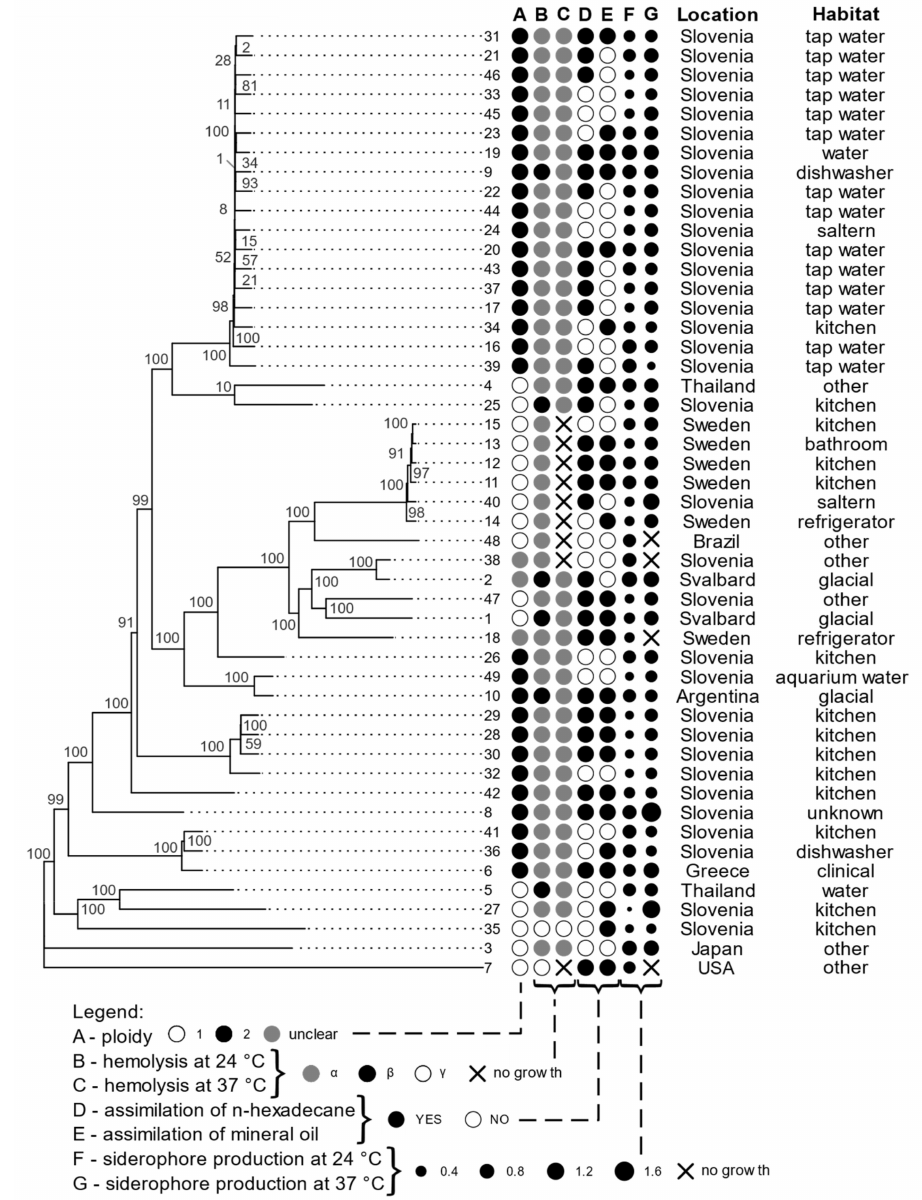
Figure 2. Phylogenomic tree of A. melanogenum strains based on whole-genome SNP data, with a selection of phenotypic traits, isolation location, and habitat. Column A of circles represents ploidy, B and C represent hemolysis at 24 ◦ C and 37 ◦ C, D and E show assimilation of n hexadecane and mineral oil, F and G show siderophore production at 24 ◦ C and 37 ◦ C (the size of the dots corresponds to the logarithmic scale of siderophore production). The ploidy of strains with genome sizes between the expected haploid and diploid sizes was marked as